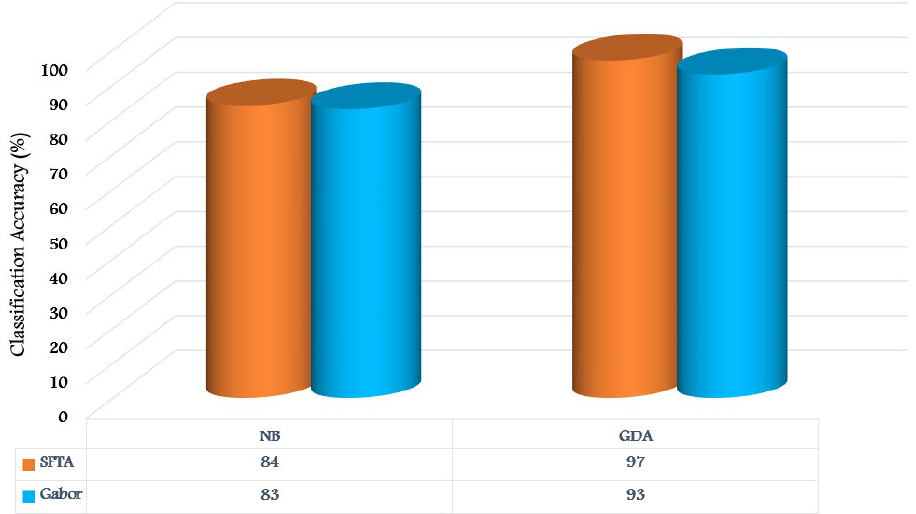
Figure 8. Detection Accuracy Rate of Proposed Method.